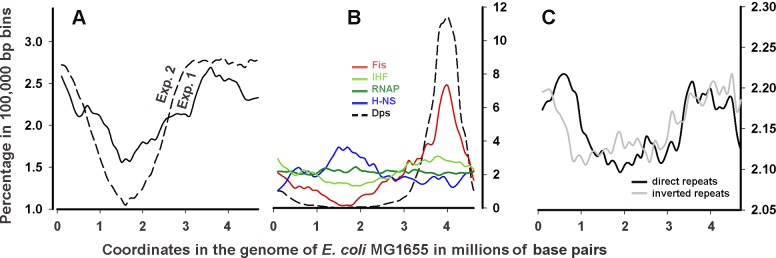
Large-scale profiles of the Dps targets correlate with the landscape of direct and inverted repeats and the pattern of Fis binding sites.A: Distribution of the Dps contact regions along the E. coli MG1655 genome identified by CLC GW in two experiments (the default settings). The areas covered by Dps are combined in 100,000 bp bins and plotted as percentage to the total length of all sites occupied by Dps. B: The same for the contact sites of Fis [49], IHF [51], H-NS [49] and RNAP [50] from the cells grown in conditions similar to those used in our experiments. The plot for Dps shows the distribution of the sites from the combined set (CS) (Page 3, S3 Table). C: The same for direct (5–24 bp separated by 1–15 bp) and inverted (5–18 bp separated by 3–20 bp) repeats collected from the genome of E. coli MG1655 using Unipro UGENE [53].